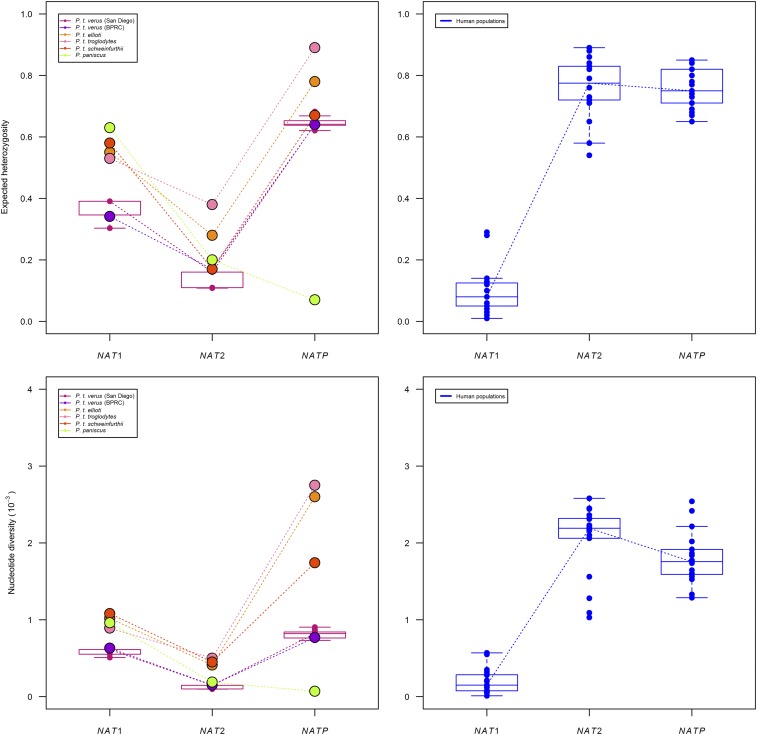
Expected heterozygosity (h) and nucleotide diversity (π x 10−3) at the three NAT genes in Pan species and sub-species (left panes) and in human populations (right panes). The variation of values among the 122 San Diego P. t. verus sub-samples (left panes) and among human populations samples (right panes) are shown by boxplots. The dotted lines were added to the graphs to highlight inter-locus variation. For Pan, P-values of Wilcoxon rank-sum tests after adjustment for multiple testing (and using only the average value for the San Diego sample) were of 0.039 for NAT1
vs.
NAT2, 0.065 for NAT1
vs.
NATP, and 0.065 for NAT2
vs.
NATP, respectively, for differences in expected heterozygosity (h), and of 0.0065 for NAT1
vs.
NAT2, 0.5887 for NAT1
vs.
NATP, and 0.0974 for NAT2
vs.
NATP, respectively, for differences in nucleotide diversity (π). When restricting the tests to the chimpanzee (P. troglodytes) data only, P-values were of 0.012 for NAT1
vs.
NAT2, 0.222 for NAT1
vs.
NATP, and 0.012 for NAT2
vs.
NATP, respectively, for expected heterozygosity, and of 0.036 for NAT1
vs.
NAT2, 0.018 for NAT1
vs.
NATP, and 0.018 for NAT2
vs.
NATP, respectively for nucleotide diversity. For human populations, adjusted Wilcoxon rank-sum tests P-values for differences in both expected heterozygosity and nucleotide diversity were all < 0.0001 in the comparisons of NAT1
vs.
NAT2, and NAT1
vs.
NATP, and of 0.58 and 0.048 for expected heterozygosity and nucleotide diversity, respectively, in the NAT2
vs.
NATP comparison.